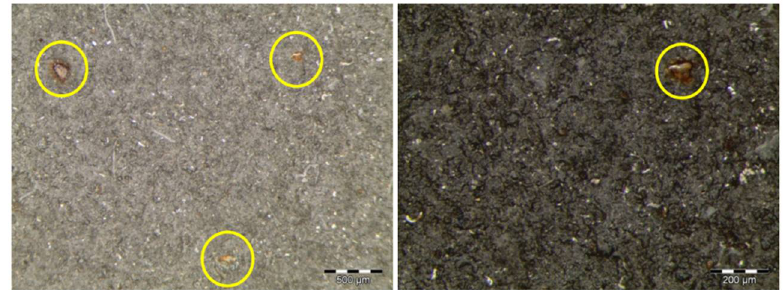
Figure 3. Optical microscopies of the C1 coating surface showing isolated ferric corrosion pits.